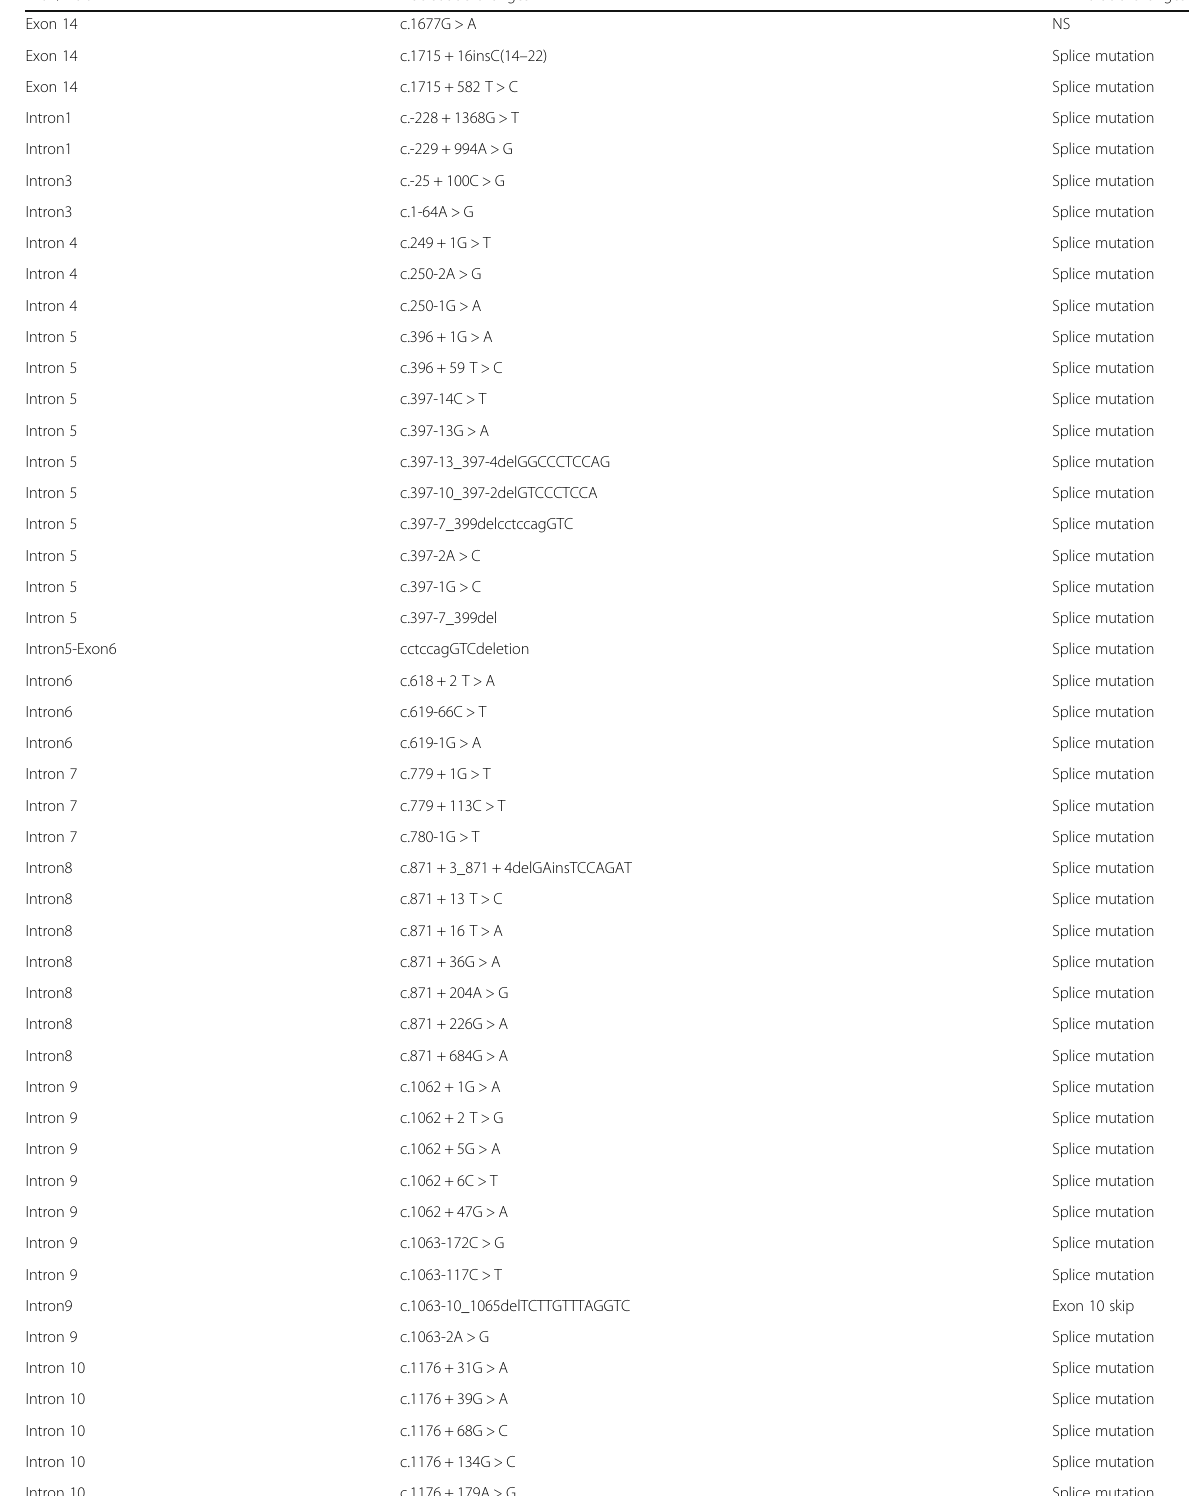
Table 1 Germline mutations in Birt-Hogg-Dubé syndrome